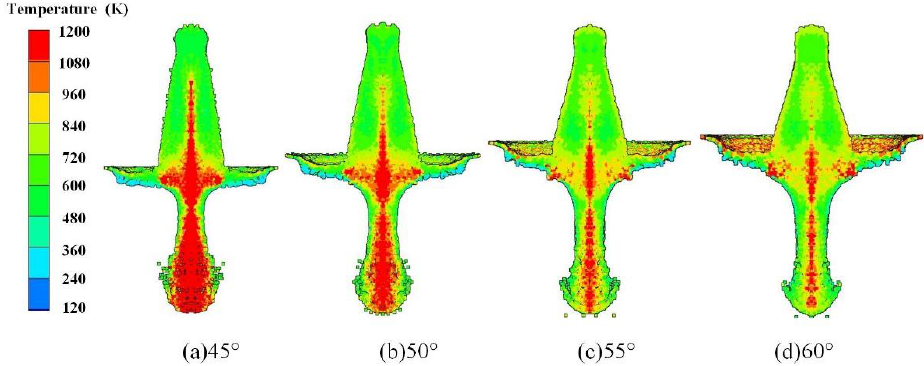
Figure 11. Reactive composite jet temperature gradient distribution influenced by the cone angle.